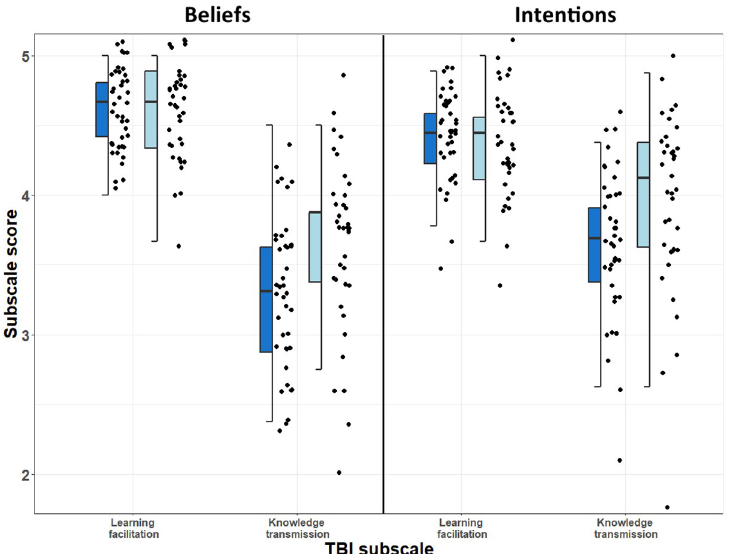
Fig 2. Faculty subscale scores (1–5) for the teaching beliefs and intentions instrument [10]. Dark blue represents FIRST IV faculty (N = 40) and light blue represents comparison faculty (N = 40). The beliefs and intentions of FIRST IV faculty were less likely to align with knowledge transmission teaching practices, as compared to their peers (paired Wilcoxon signed-rank test: Beliefs P = 0.008, Cohen’s d = 0.6; Intentions P = 0.016, Cohen’s d =